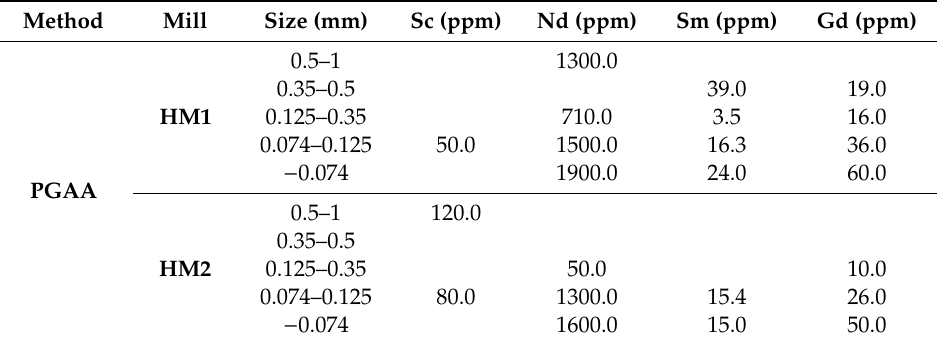
Table 6. Distribution / concentration of REE detected by the